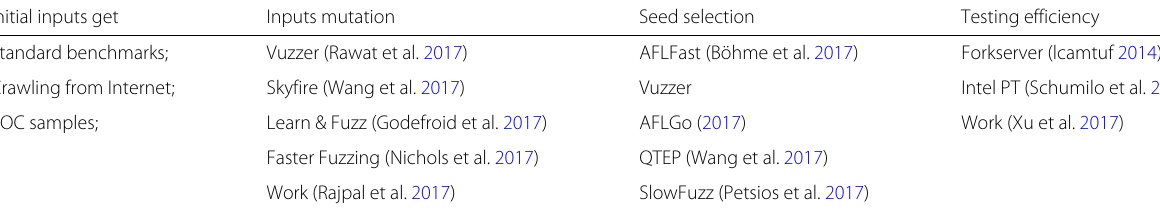
Table 4 Comparison of different techniques Initial inputs get Inputs mutation Seed